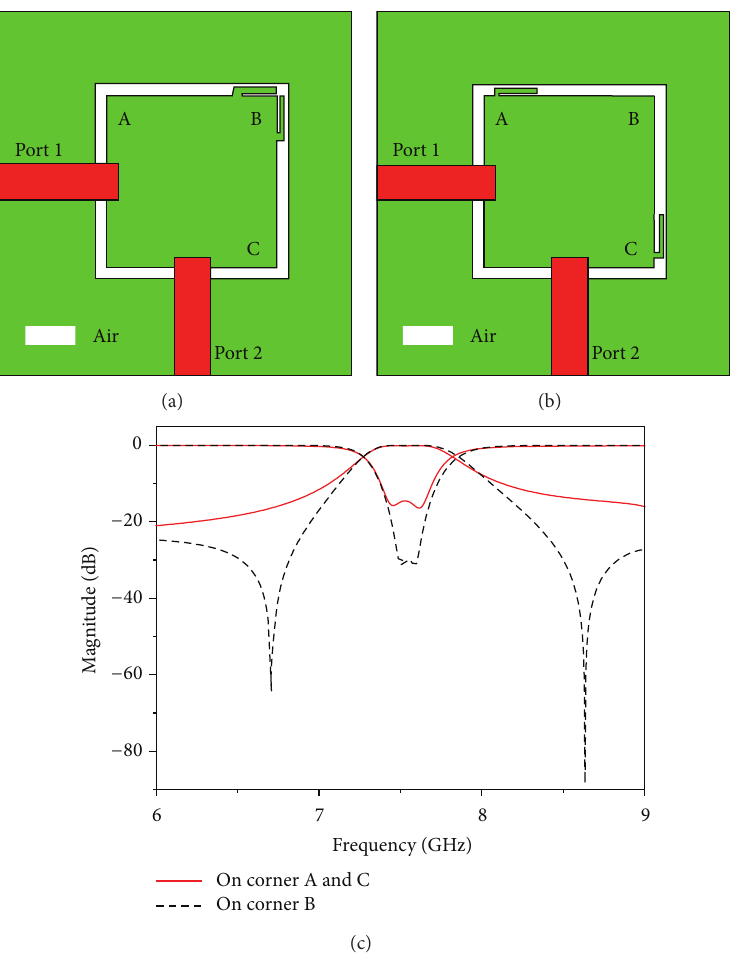
Figure 3: (a) Dual-mode square slotline resonator with the slot spurlines on corner B. (b) Dual-mode square slotline resonator with the slot spurlines on corners A and C. (c) Their simulated frequency response, where the black dash line is for (a) and the red line is for (b).